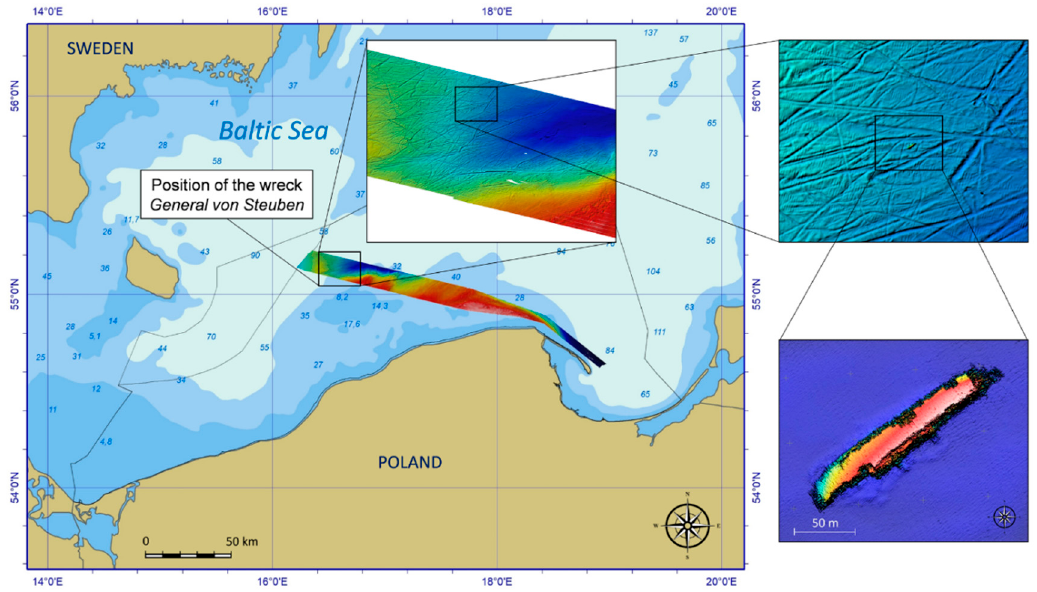
Figure 2. Site of discovery of the General von Steuben shipwreck.